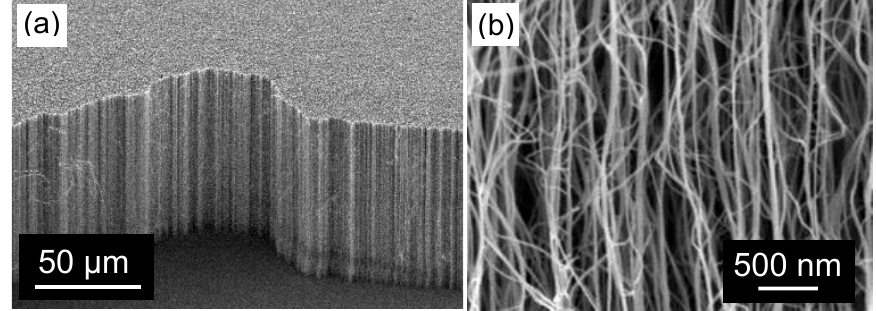
Figure 12. SEM images of a CNT forest grown by chemical vapor deposition on a silicon substrate: (a) low magnification (~35° sample tilt) and (b) higher magnification (2 kV, 9 mm working